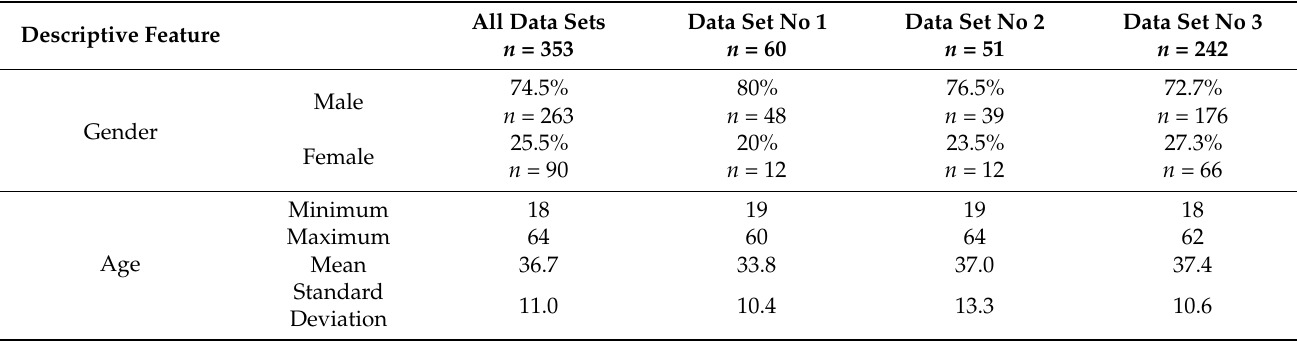
Table 1. Descriptive characteristics of the participants.